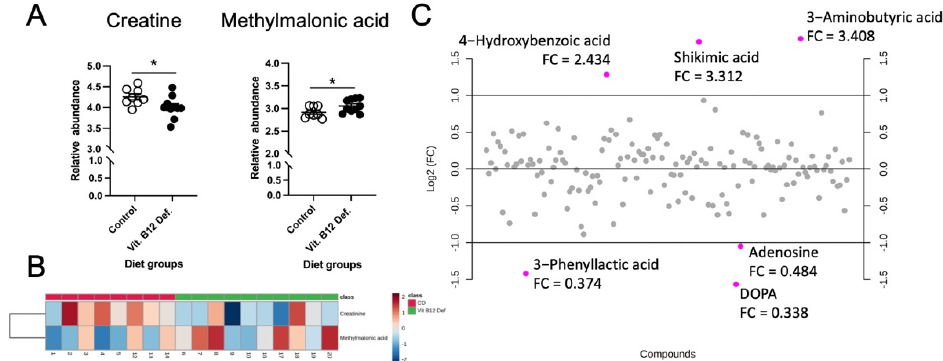
Figure 6. Impact of dietary vitamin B12 deficiency and ischemic stroke on cecum metabolomics. Significance testing, heatmap visualization, and fold change (FC) analysis of metabolite data. Data were normalized to sample weight and log-transformed prior to analysis; samples were unpaired, equal group variances assumed, and parametric test performed. ( A ) Significant between-group metabolites as determined by independent samples t -test: creatinine ( p = 0.04), methylmalonic acid ( p = 0.04). ( B ) Heatmap display of creatinine and methylmalonic acid. ( C ) FC analysis (performed as B12-deficient/control diet) showed three metabolites with FC > 2 (4-hydroxybenzoic acid, shikimic acid, 3 − aminobutyric acid) and three metabolites with FC < 0.5 (3 − phenyllactic acid, DOPA, adenosine). * p < 0.05, un-paired t -test.